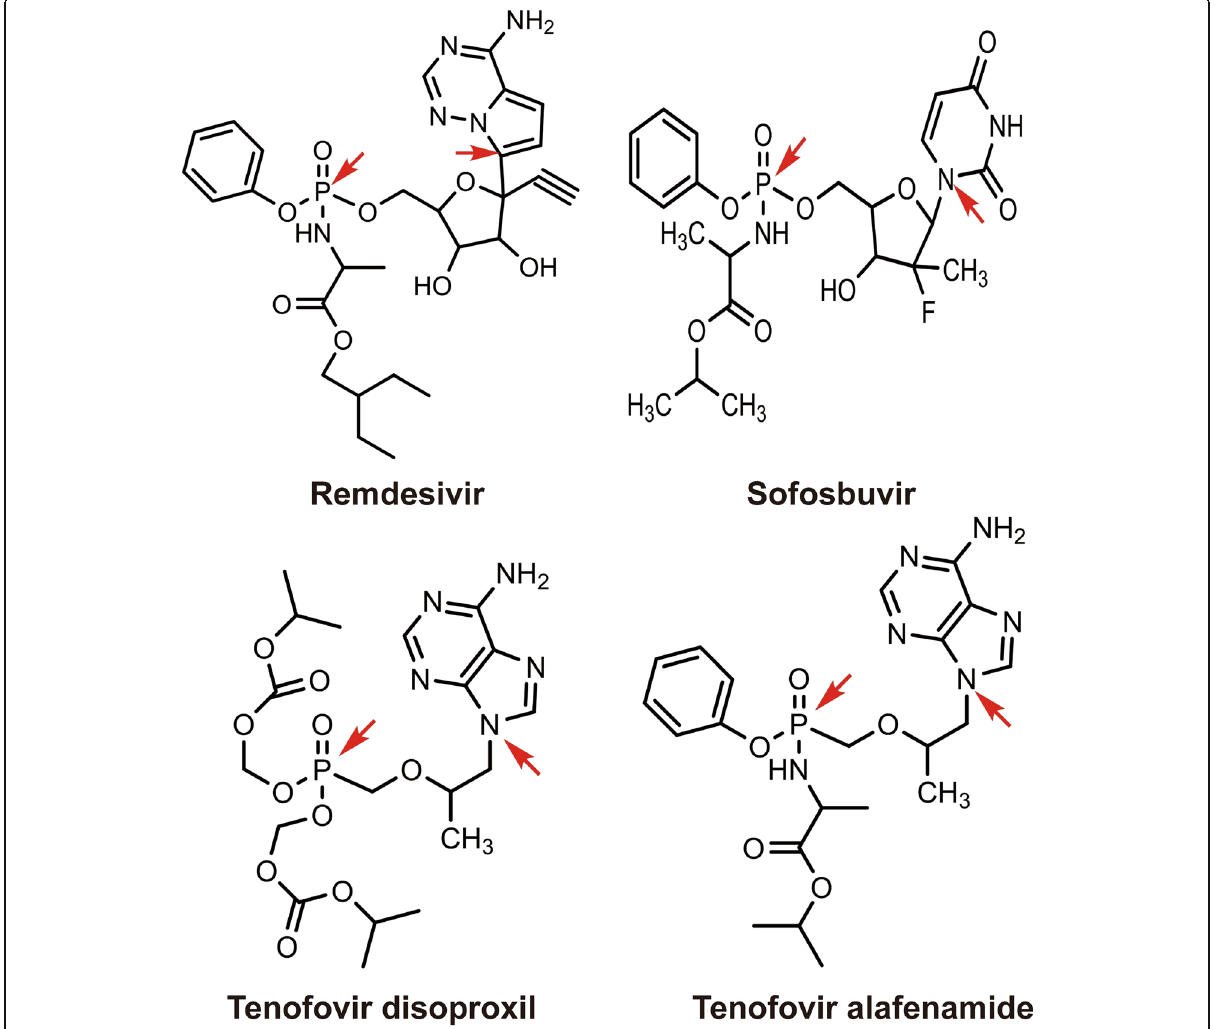
Fig. 1 Chemical structure of remdesivir, sofosbuvir, tenofovir disoproxil and tenofovir alafenamide Those are nucleoside/nucleotide drugs featured by the heterocyclic ring linked to the phosphorus atom at the center. The connecting atoms are pointed by a red